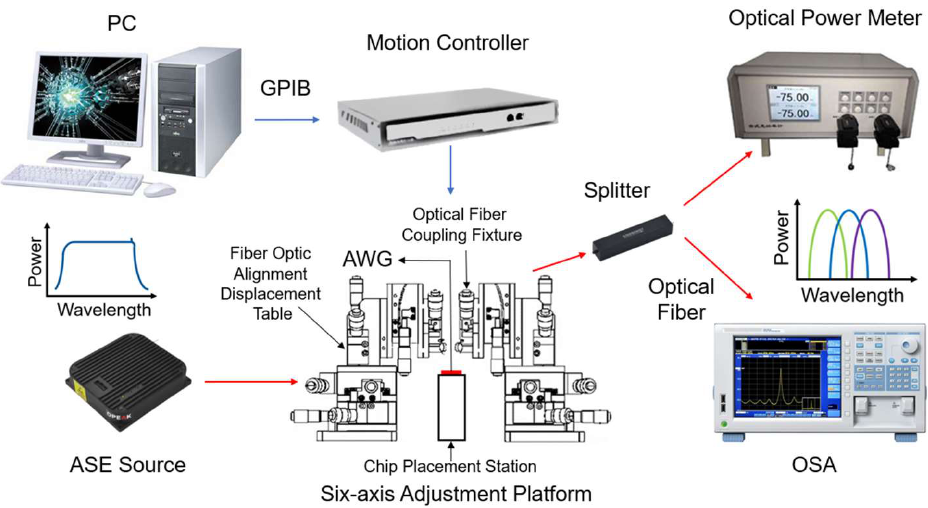
Figure 10. Testing system for the spectrum measurement of the fabricated AWG.